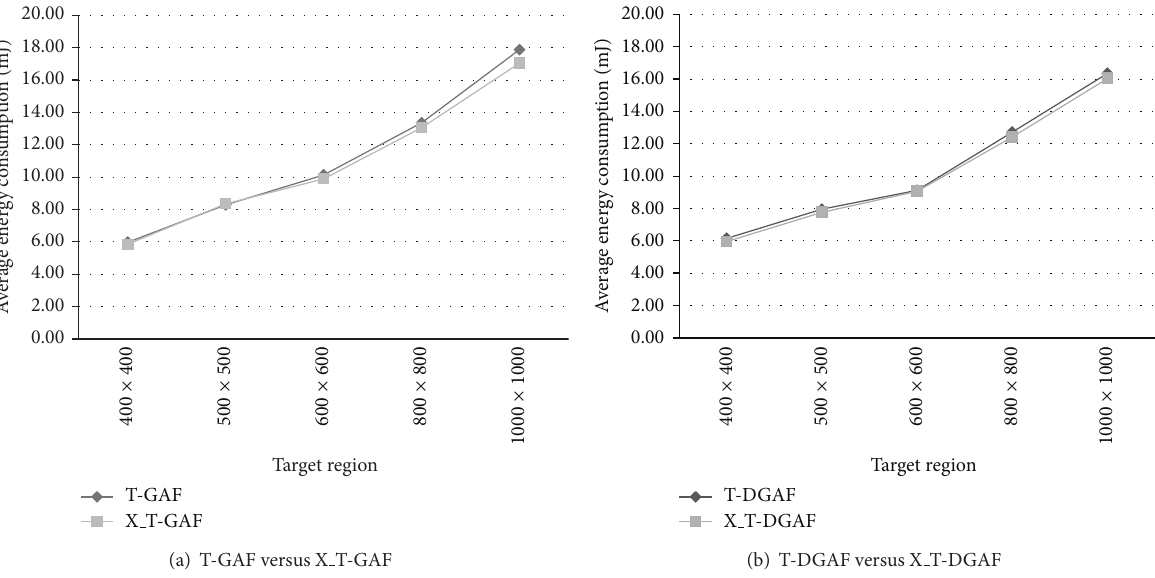
Figure 10: Comparison of the average energy consumption of T-GAF/T-DGAF with the proposed coordination election scheme using residual energy versus combination residual energy and the location of sensors within the grid (i.e., X T-GAF/X T-DGAF). 00.511.522.533.5